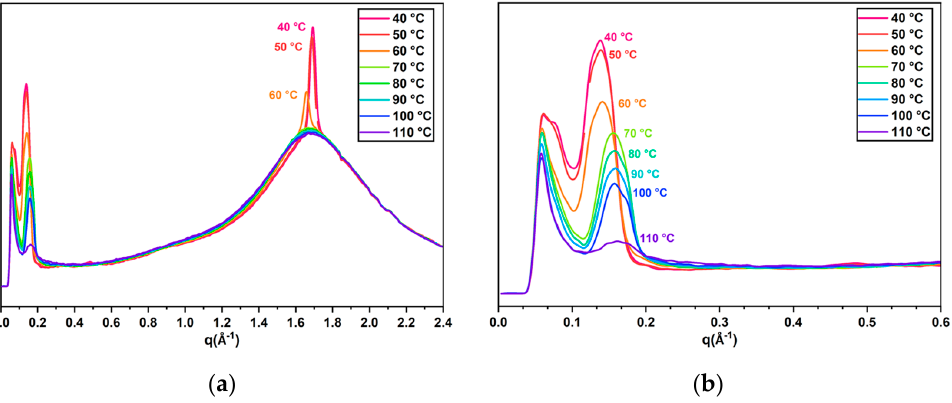
Figure 4. ( a ) XRD of CLC oligomers with 25% Monomer 2 at different temperatures under cooling. ( b ) Amplified peaks at q = 0.14 Å -1 for different temperatures, which indicate the existence of ( b ) Amplified peaks at q = 0.14 Å − 1 for different temperatures, which indicate the existence of smectic smectic phase order. phase